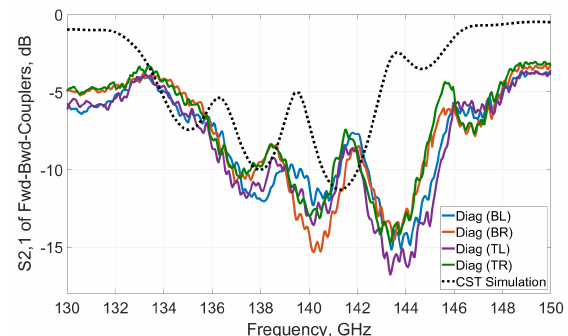
Figure 15. Transmission through the fundamental mode waveg- uides with the diagonal coupler structures. The simulation does not account for attenuation outside of the coupling structure re- gion.